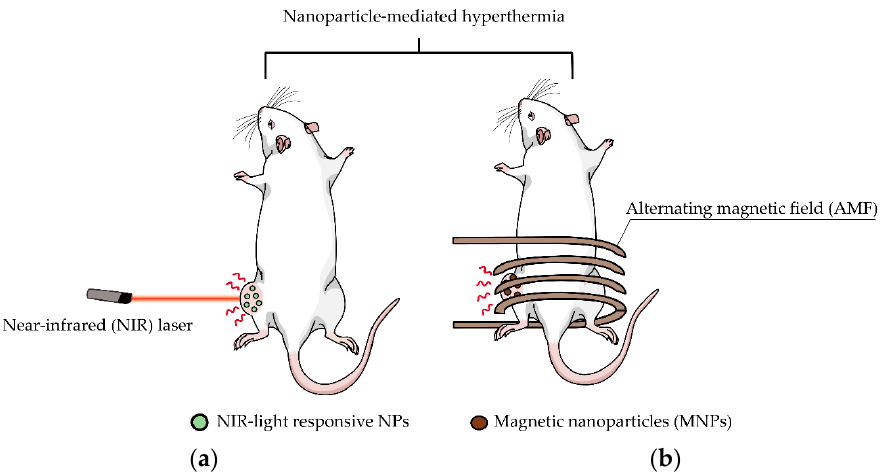
Figure 1. Schemes of nanoparticle (NP)-mediated hyperthermia. ( a ) Photothermal therapy (PTT) by near-infrared (NIR) laser irradiation to the tumor region, and ( b ) magnetic hyperthermia therapy (MHT) by alternating magnetic field (AMF) application.